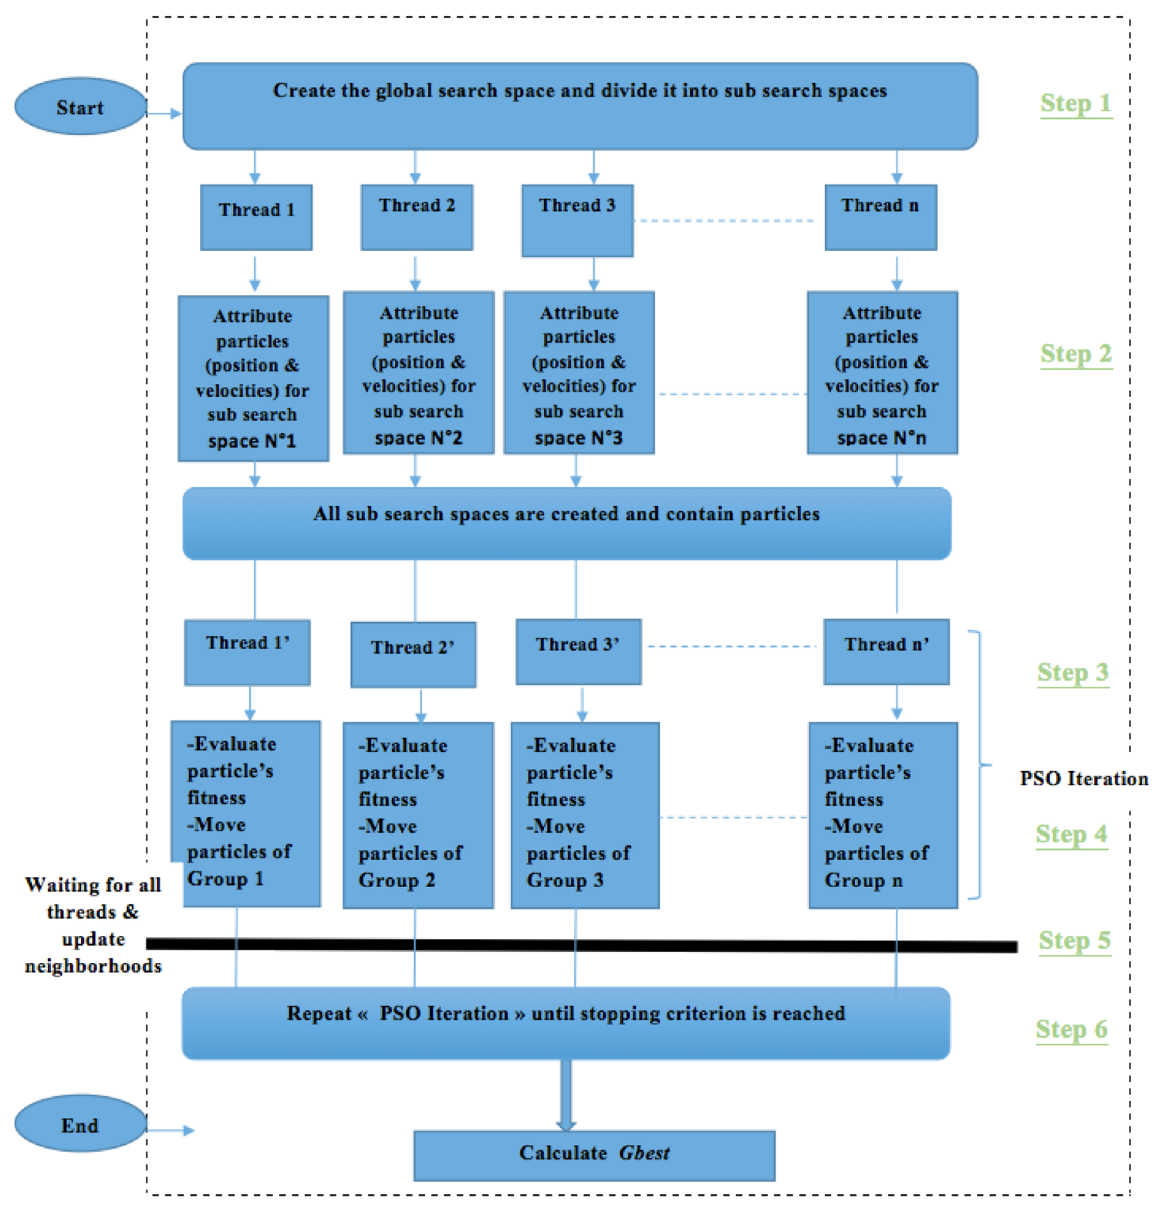
Fig. 3. The proposed NPM